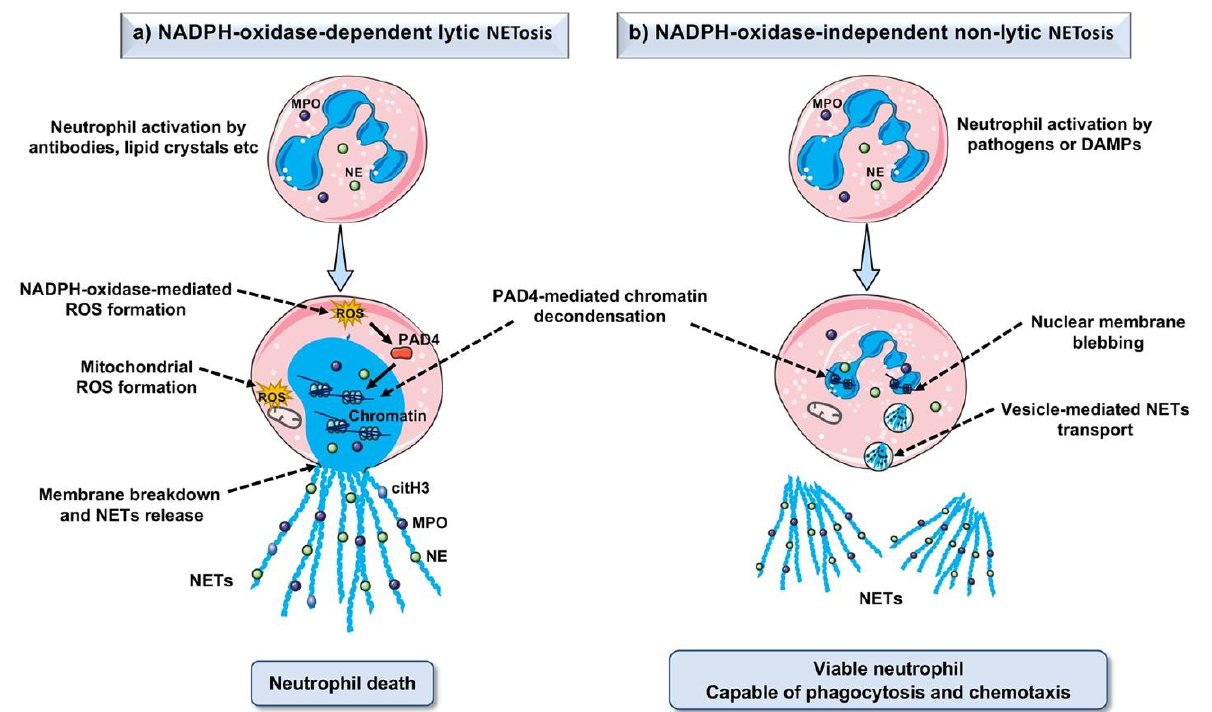
Figure 1. Mechanisms of NET formation. ( a ) NADPH-oxidase (NOX)-dependent lytic NET formation: After activation, neutrophils produce reactive oxygen species (ROS) via the NADPH-oxidase complex. ROS activates or upregulates protein-arginine deaminase type 4 (PAD4, which promotes citrullination of histones and subsequent chromatin de-condensation). Myeloperoxidase (MPO) helps translocate neutrophil elastase (NE) into the nucleus, which leads to further chromatin de-condensation, finally the nuclear membrane is disrupted, and NETs decorated with granular and cytosolic proteins are released in extracellular space. Neutrophils die after NET formation. ( b ) NADPH-oxidase (NOX)-independent non-lytic NET formation: After neutrophils activation by pathogens or DAMPs, PAD4 promotes chromatin de-condensation. NETs decorated with granular and cytosolic proteins are released outside via vesicular transport without plasma membrane disruption. After the release of NETs, neutrophils remain viable, and capable of phagocytosis and